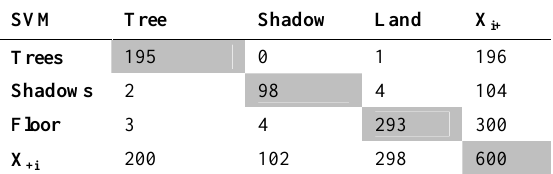
Table 2: Confusion matrix of the SVM classification approach.